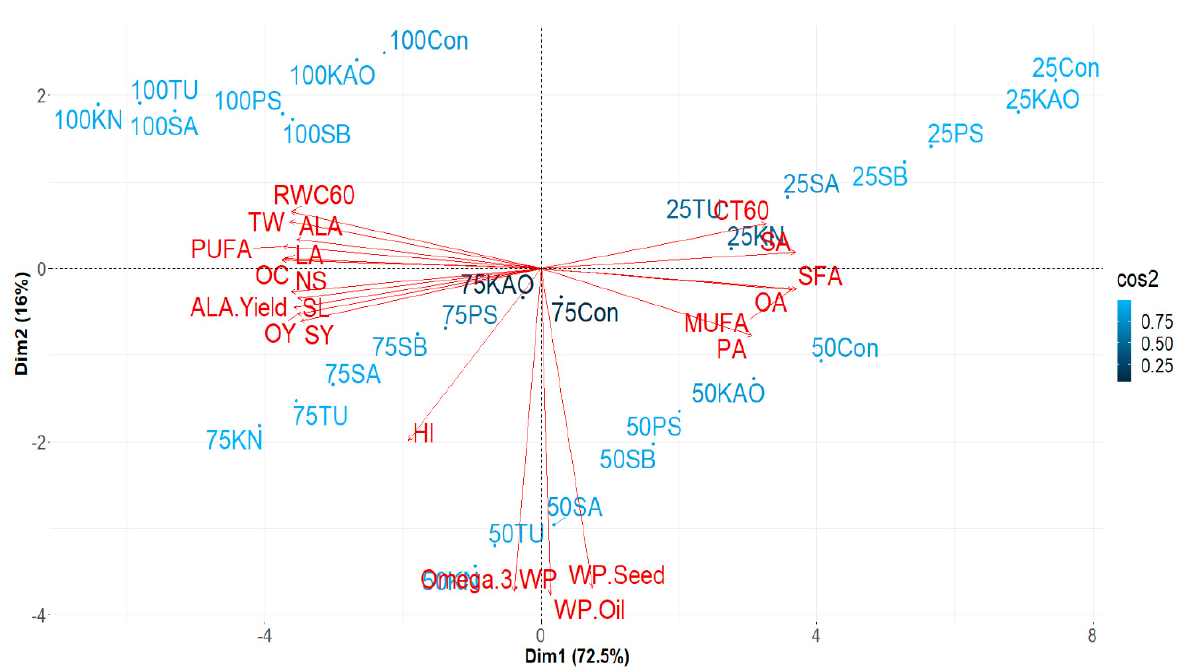
Figure 6. PCA biplot showing interrelation between traits such as seed yield (SY), oil content (OC), oil yield (OY), test weight (TW), number of spikes (NS), spike length (SL), linoleic acid yield (ALA), relative water content (RWC), canopy temperature (CT), polyunsaturated fatty acids (PUFA). Saturated fatty acid (SFA), oleic acid (OA), palmitic acid (PA), stearic acid (SA), linoleic acid (LA), linolenic acid (ALA), water productivity (WP) grown under irrigation regimes (100, 75, 50, and 25% CPE) with various bioregulators. Variables represented by vectors (red markings) and irrigations in loadings (blue markings).